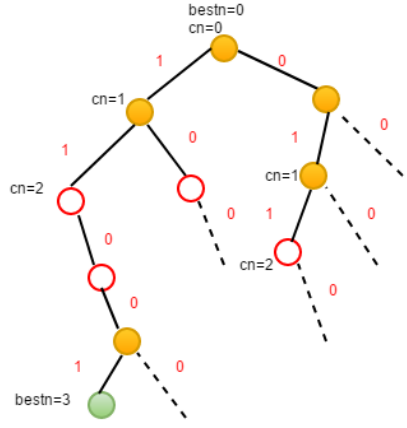
Figure 11. Tree for solving the maximum clique problem by the backtracking